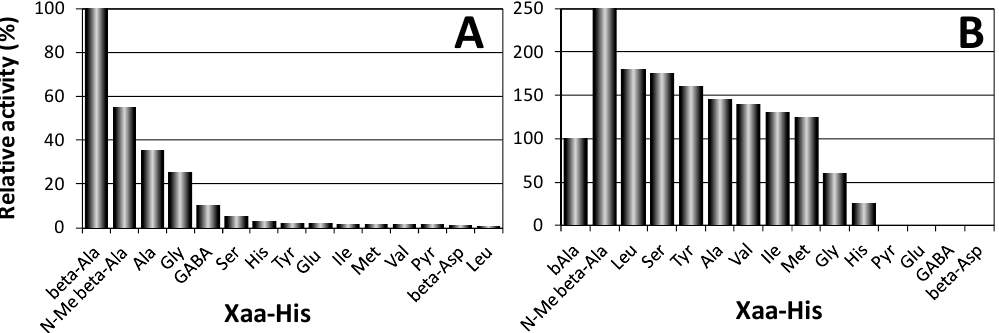
Figure 3. Hydrolysis activity of human CN1 (A) and CN2 (B) towards several Xaa-His dipeptides